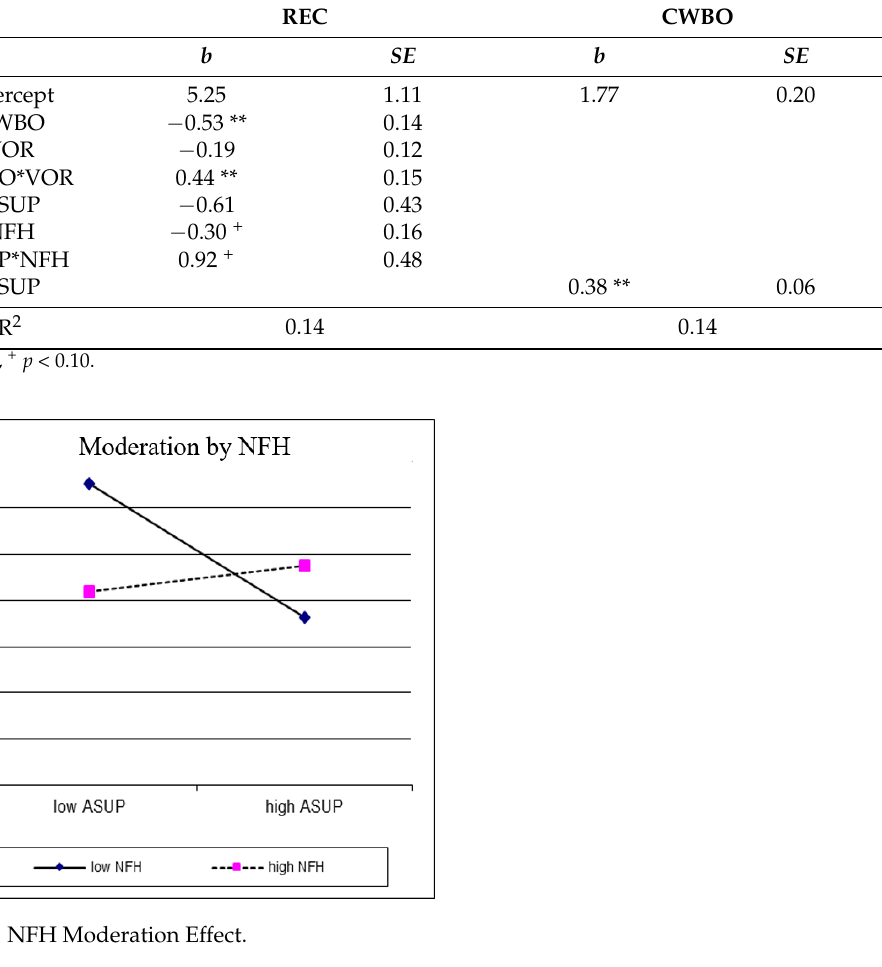
Figure 4. NFH Moderation Effect.